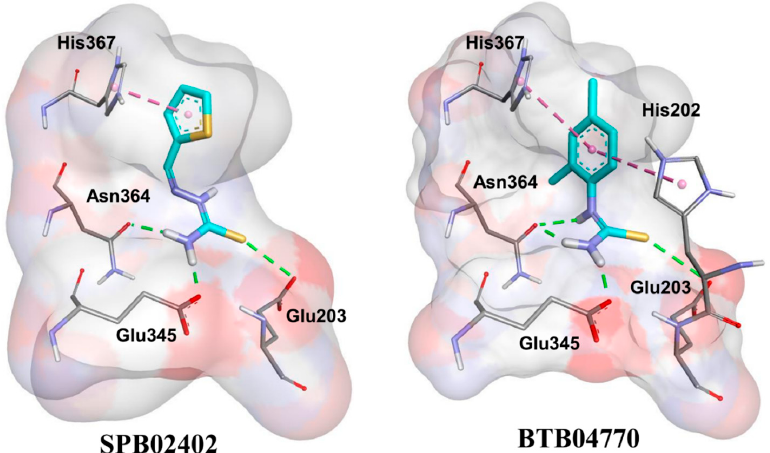
Figure 4. Molecular docking performed for the two representative inhibitors in the human tyrosinase model structure. The tyrosinase inhibitors and tyrosinase amino acids are shown as cyan and grey sticks, respectively. The pi–pi interactions and hydrogen bonds are shown as dotted lines. Only the interacting residues are shown for clarity by hiding the Cu ions, water molecule, and other tyrosinase residues in the surface background of human tyrosinase’s active site. Molecules 2021 , 26 , x